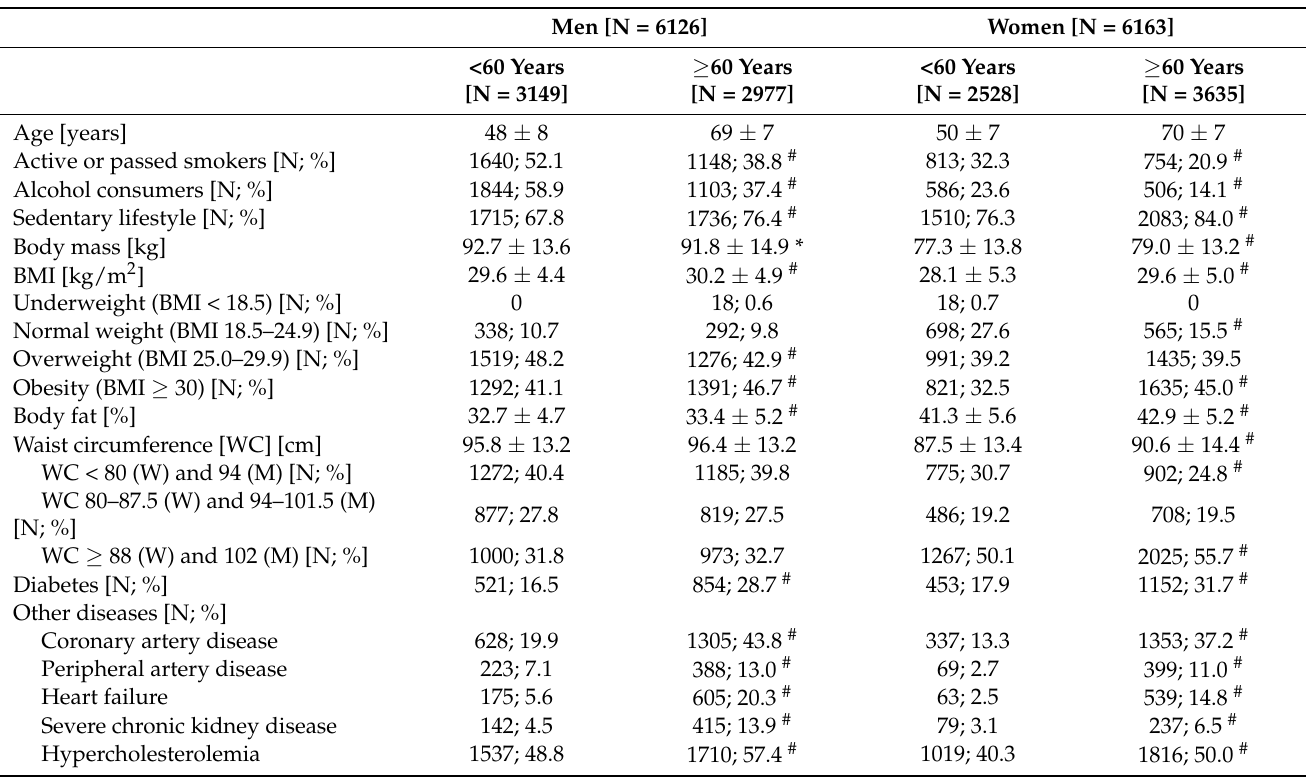
Table 1. Characteristics of men and women on antihypertensive pharmacotherapy, stratified by